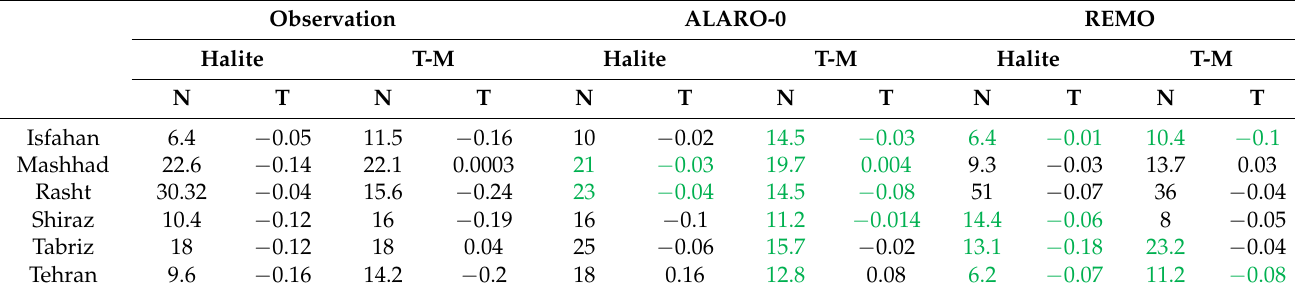
Table 4. Model performance for the annual number of transitions of halite and thenardite–mirabilite (T-M). (N, number of phase transitions; T, trend slope (Year − 1 )). Modelled values marked in green fall within the range of observations